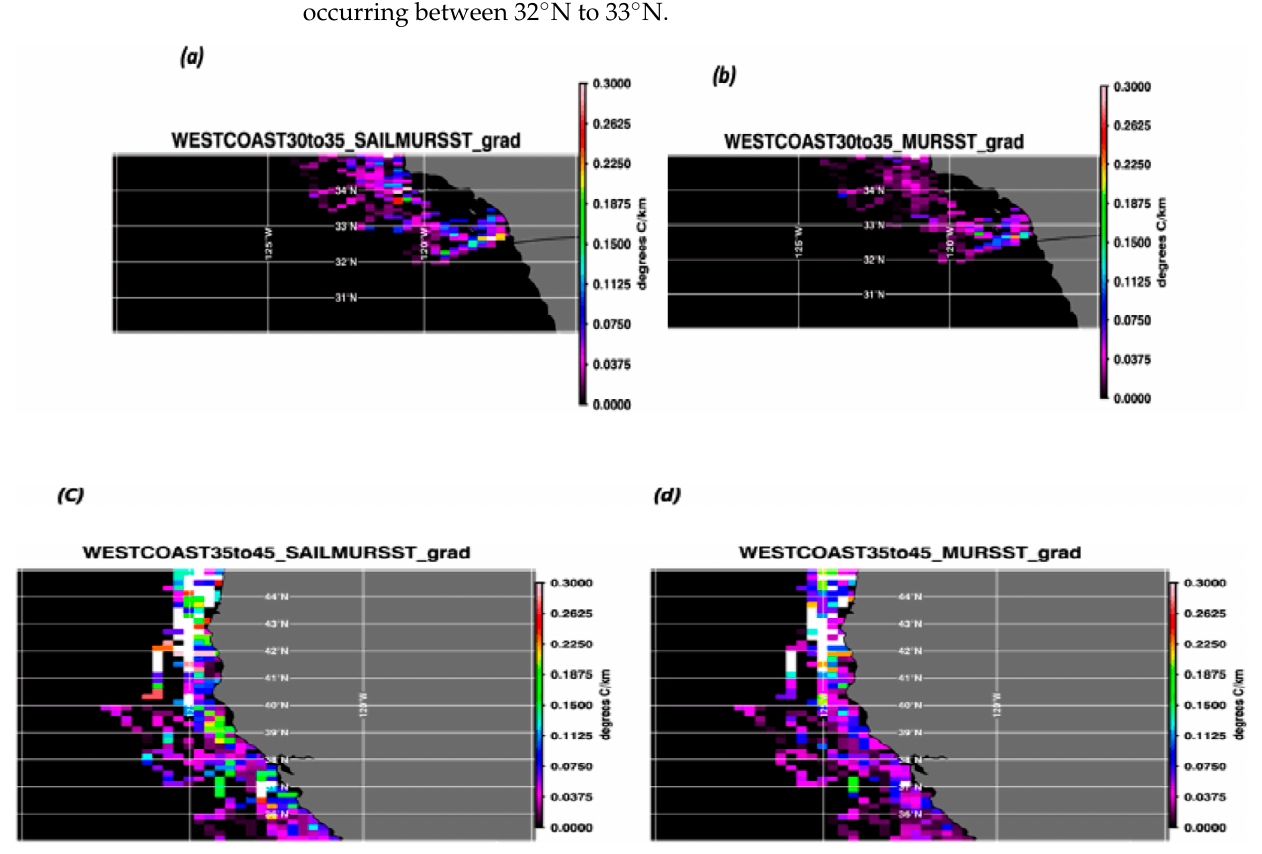
Figure 2. ( a – d ). ( a ) SAILSST gradients along the Saildrone deployment from 30°N to 35°N derived using the SBE/CTD data, ( b ) MURSST gradients from the MUR co-located data from 30°N to 35°N, ( c ) SAILSST gradients along the Saildrone deployment from 35°N to 42°N derived using the SBE/CTD data, and ( d ) MURSST gradients from the MUR co-located data from 35°N to 45°N. Figure 3 shows the salinity derived gradients based on the JPLSSS product compared to the Saildrone SBE/CTD. Between 30°N to 35°N consistently high gradients are clearly visible between 32°N to 33°N. However, JPLSSS appears to have a larger area covered by